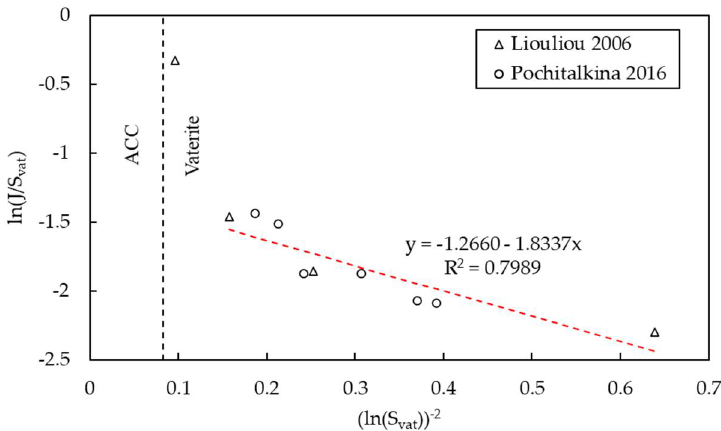
Figure 8. Linearized fit of the kinetically limited nucleation rate for vaterite. The black dashed line indicates where supersaturation for ACC begins. The data point of Pochitalkina close to ACC supersaturation is not used for the fit, as the classical nucleation theory starts to break down for small critical nuclei.